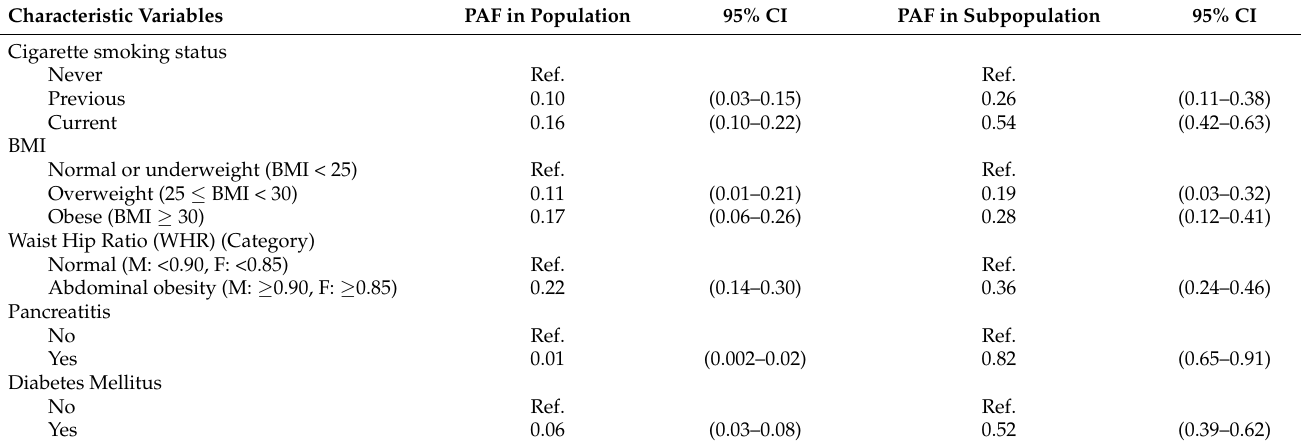
Table 4. Population attributable fraction (PAF) of modifiable risk factors among population and